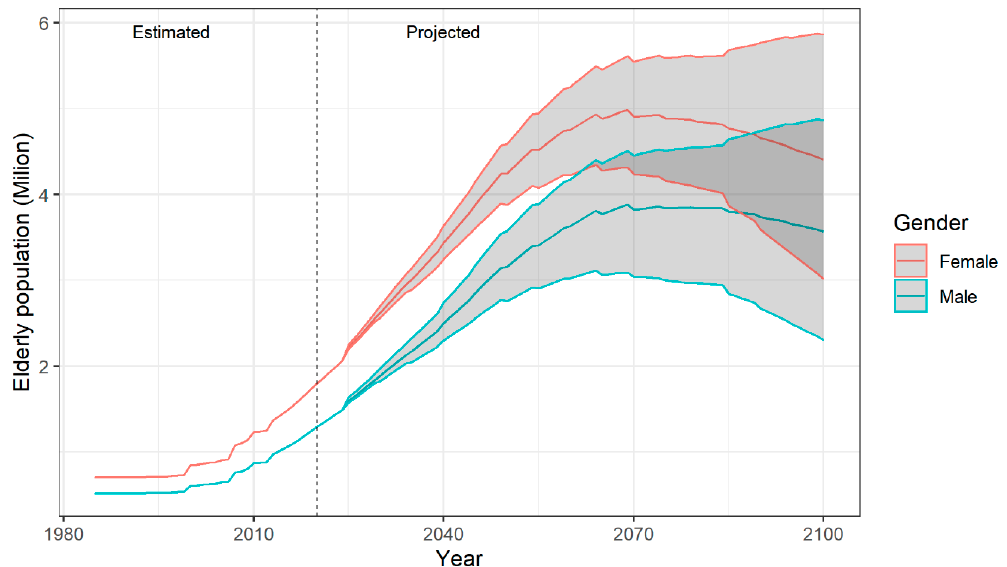
Figure 1. Elderly population in the Metropolitan Region of Sao Paulo (MRSP) by gender with the confidence interval of 95% (Shaded). The red color represents the female elderly population and the blue represents the male elderly population.